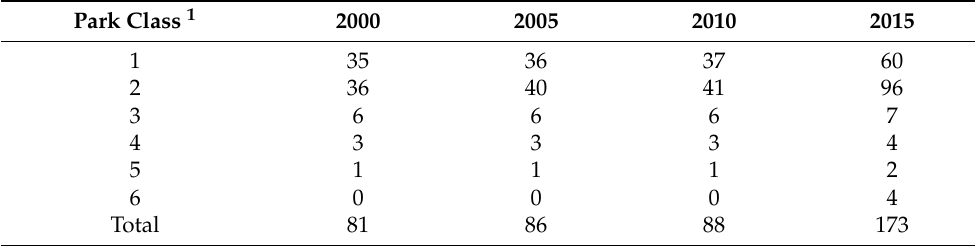
Table 1. The number of urban parks from 2000 to 2015 in Beijing.